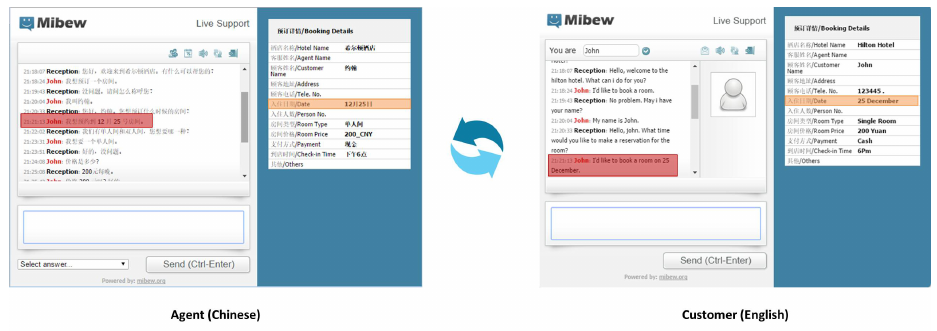
Figure 9. Illustration of decoding with